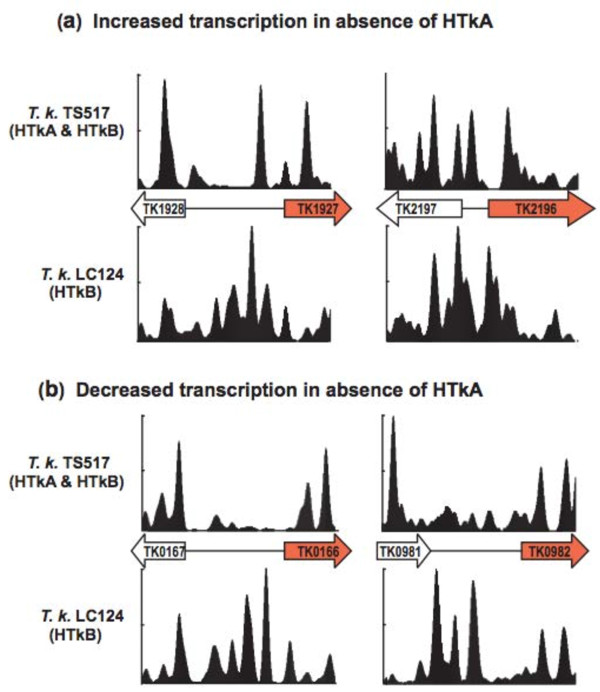
Nucleosome profiles, related to transcription changes that result from archaeal histone deletion. The profiles of nucleosomes assembled in vivo in T. kodakarensis TS517 and LC124 are respectively shown above and below the 1-kbp genomic region of interest [34,39]. Intergenic regions are depicted as a single line and the genes that (a) had increased transcription or (b) had decreased transcription in the absence of HTkA [13] are shaded red.